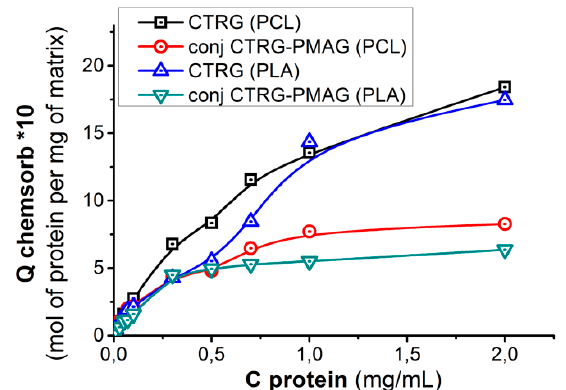
Figure 6. Isotherms of CTRG and PMAG-CTRG chemisorption on aminated PLA- and PCL-based surfaces. Conditions: 0.01 sodium M borate buffer solution, pH 8.5, 25 °C, 300 rpm.